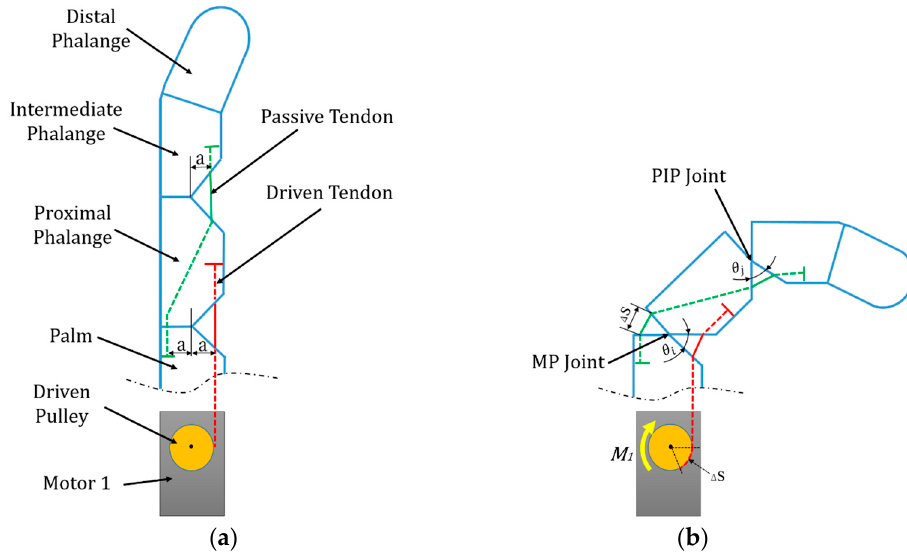
Figure 5. Stable tendon-driven mechanism of finger: ( a ) full extension state; ( b ) finger joints at with same angle.